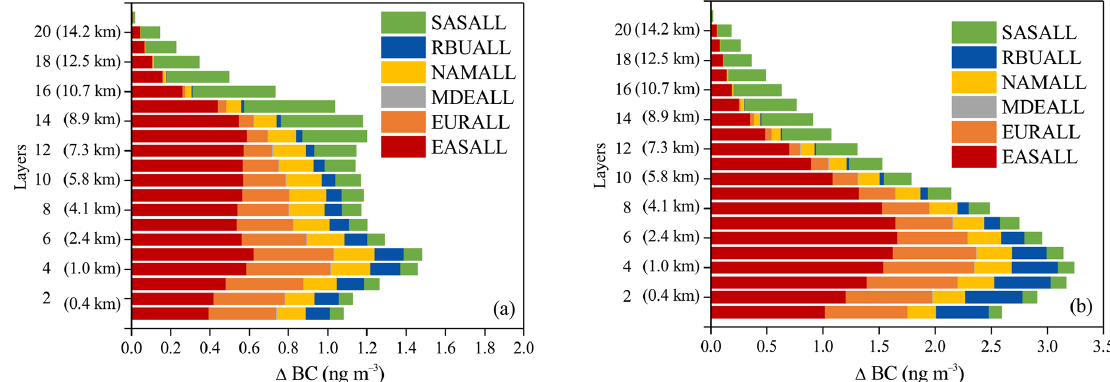
Figure 5. Contribution of 20% emission reductions from six source regions to BC concentrations in different vertical layers (a) in summer and (b) in winter in the Arctic in 2010.